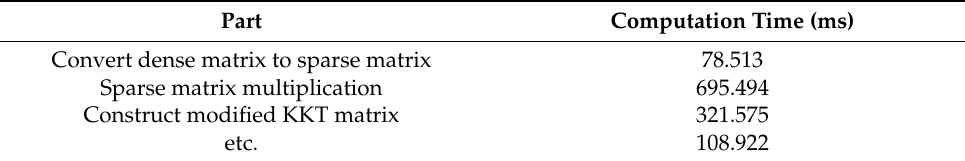
Table 3. The computation time for each process of construct modified KKT condition.